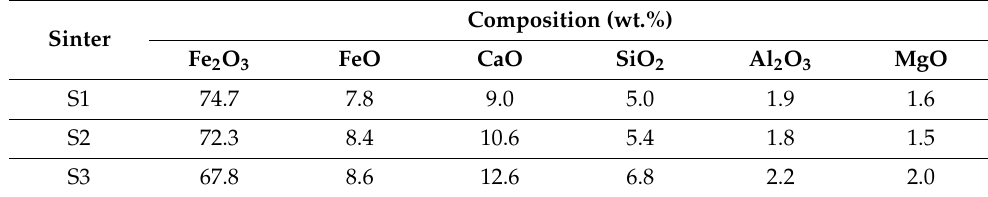
Table 1. Sinter samples used in the present study along with their bulk compositions. Composition (wt.%) Sinter Fe 2 O 3 FeO CaO SiO 2 Al 2 O 3 MgO S1 74.7 7.8 9.0 S2